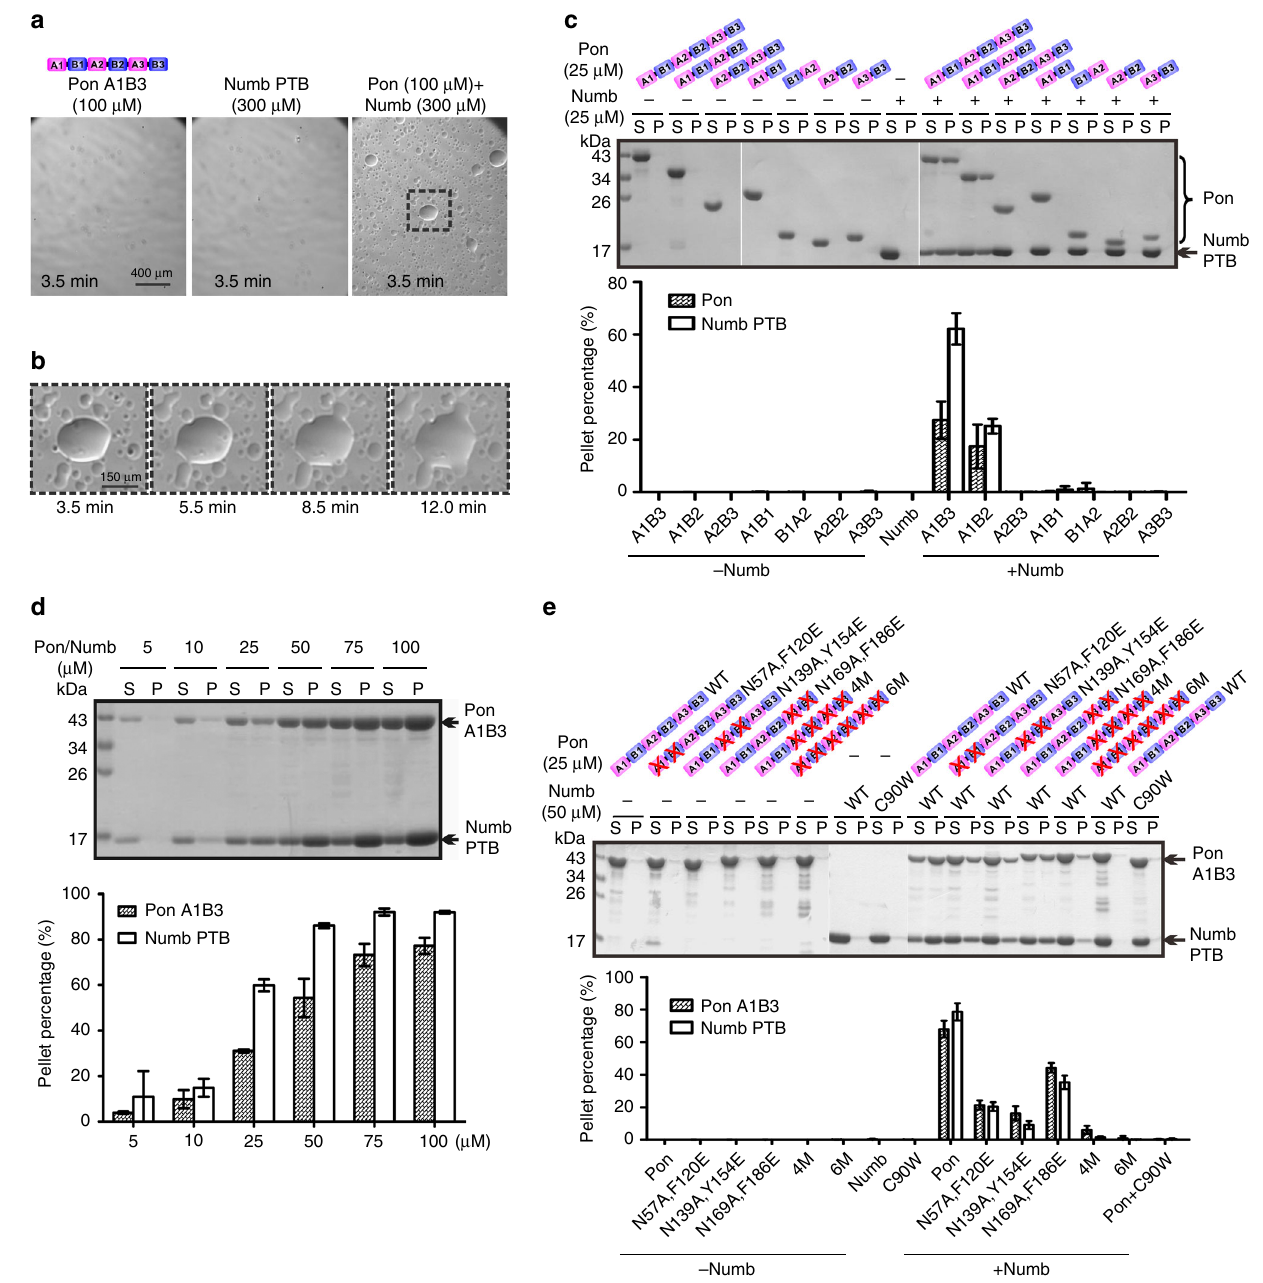
Fig. 4 Phase transition of the Numb PTB/Pon A1B3 complex. a Isolated Numb PTB and Pon A1B3 solutions are clear under light microscope at room temperature (RT). Mixing the two proteins led to formation of numerous droplets (see also Supplementary Movie 1). The images were acquired 3.5 min and onward after mixing. The dashed box is the region of zoomed-in analysis in b . b The small droplets underwent time-dependent fusion into larger ones. c Representative SDS-PAGE analysis and quanti fi cation data showing the distribution of proteins between aqueous solution/supernatant (S) and condensed liquid droplets/pellet (P) fractions for various Numb PTB/Pon fragment mixtures. Compared with Pon A1B3, Pon A2B3 is less ef fi cient to form liquid droplets by binding to Numb PTB, whereas other Pon fragments cannot form liquid droplets by binding to Numb. d Sedimentation assay showing that the phase transition of the Numb PTB/Pon A1B3 complex is concentration-dependent. Numb PTB and Pon A1B3 were mixed at a 1:1 molar ratio with fi nal concentration indicated. e Numb-Pon-binding de fi cient Pon A1B3 mutants (N57A,F120E, N139A,Y154E, N169A,F186E, 4M, and 6M) or Numb PTB mutant (C90W) showing signi fi cantly impaired phase transition when compared to the WT proteins. All statistic data in this fi gure represent the results from three independent batches of experiments and are expressed as mean ± SD. Uncropped gels are shown in Supplementary Fig.